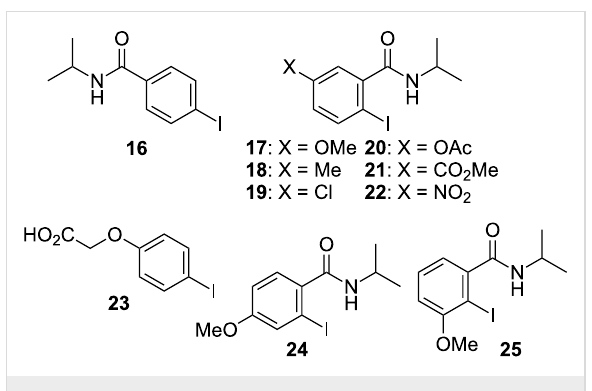
Figure 2: Structures of the catalysts 16 – 25